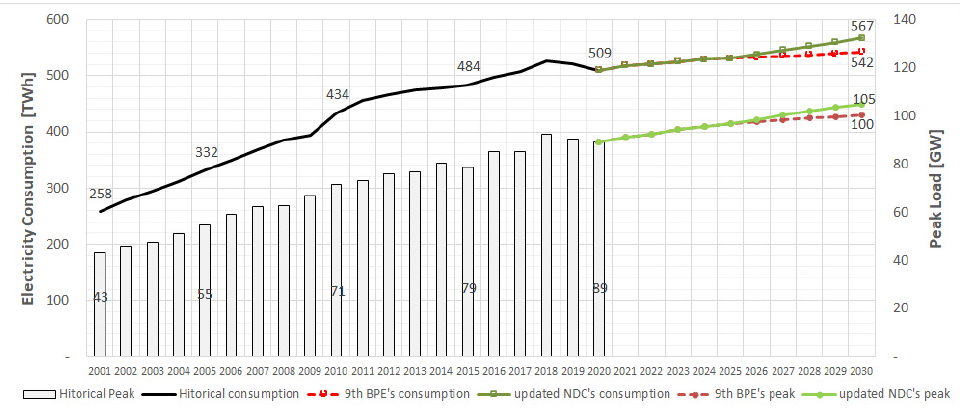
Figure 4. Historical demand and projection.